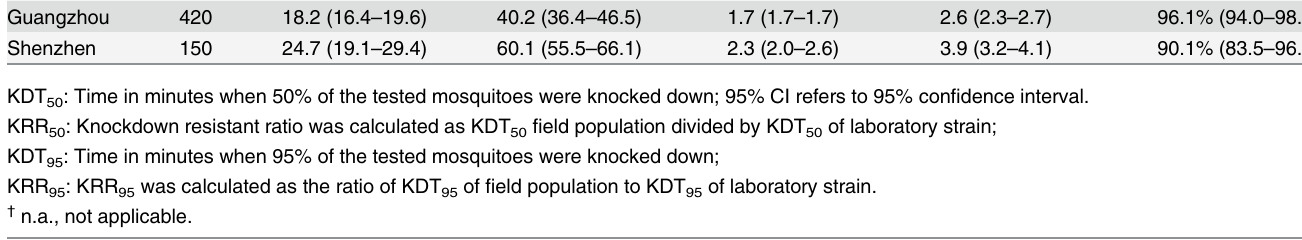
for the Guangzhou population (Table 2). Similar increase in knockdown time was also found ) in field population compared to the control population. in the 95% knockdown time (KDT 50